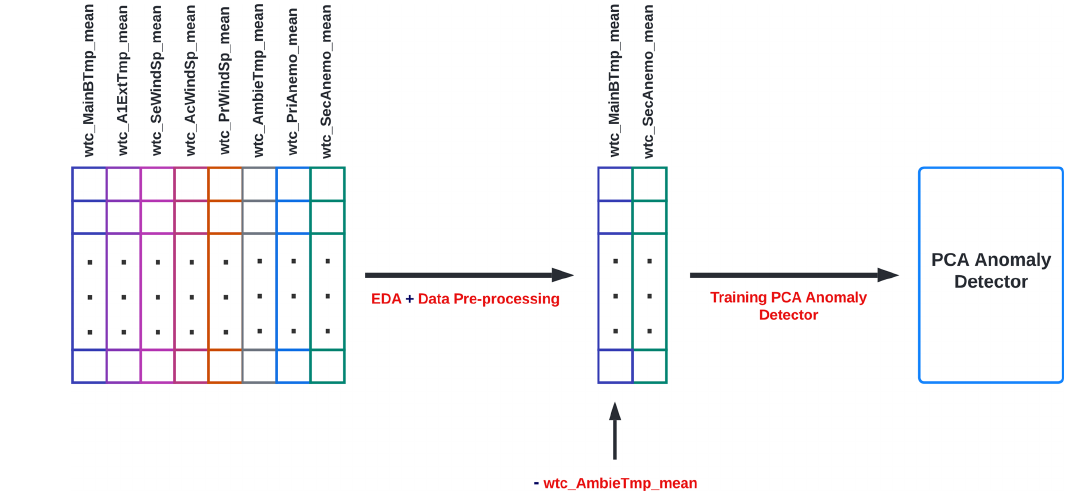
Figure 8. First phase of the stated